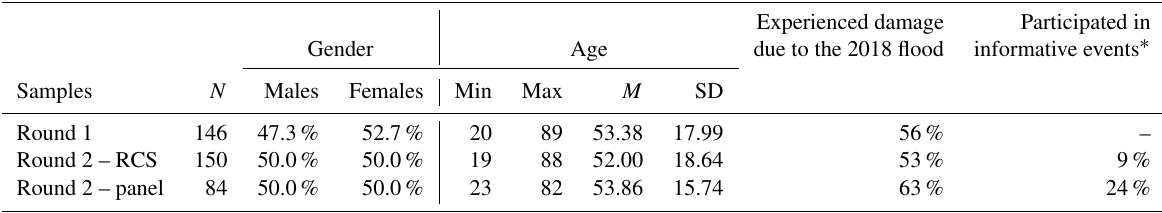
Table 1. Summary statistics of the three samples collected.